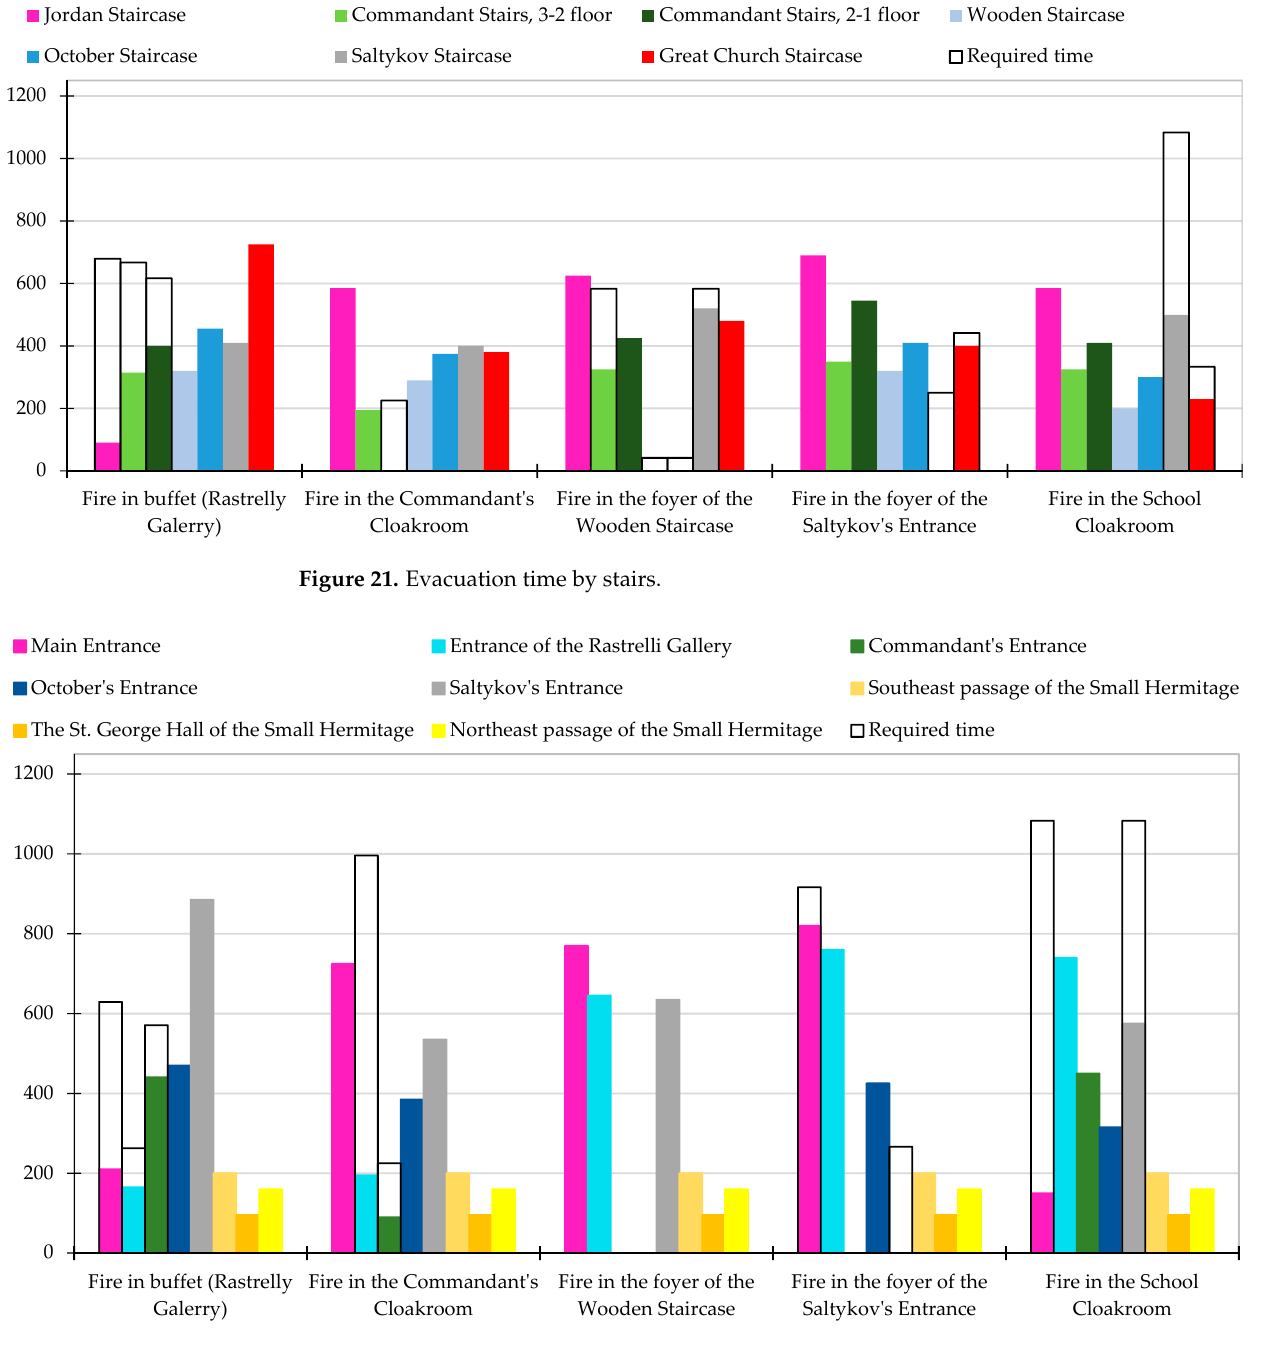
Figure 22. Evacuation time by exits of the building.